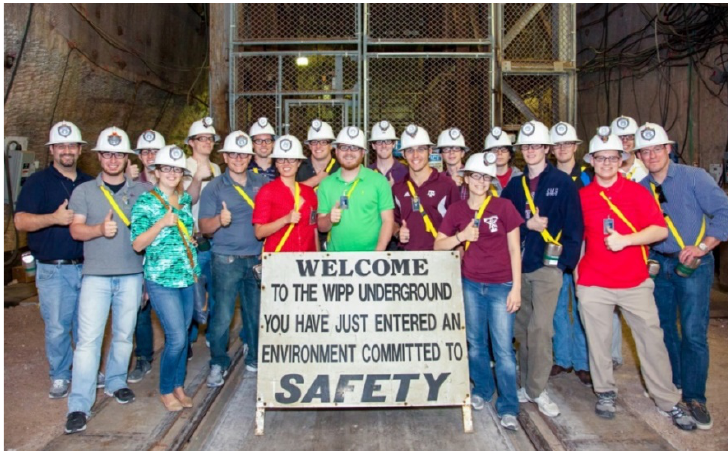
Figure 4. Texas A&M Students at the U.S.’s Waste Isolation Pilot Plant in